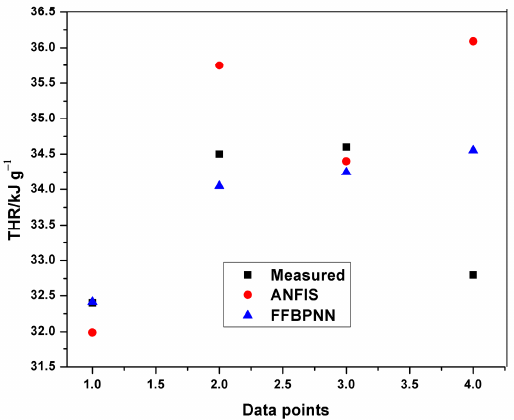
Figure 14. Comparison of THR training results.